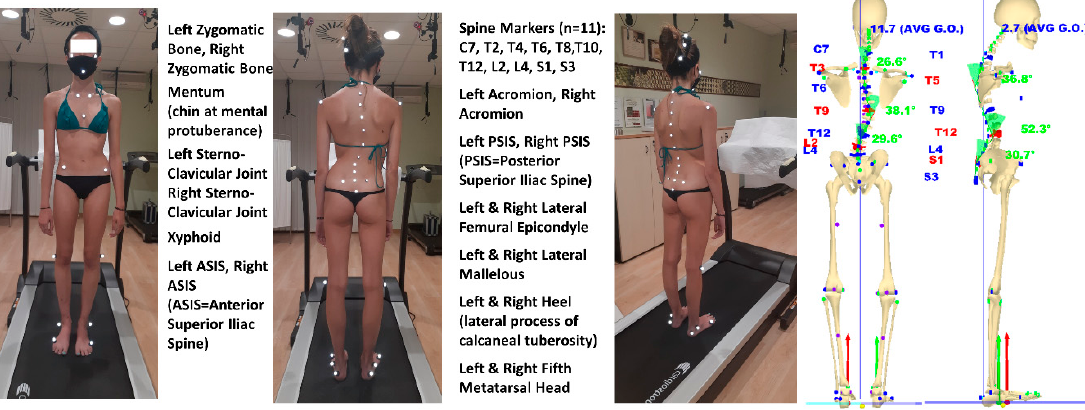
Figure 2. Simplified protocol for 3D posture, gait and run analysis: a list of 31 anatomical landmarks identified by palpation plus a three-marker headband set.